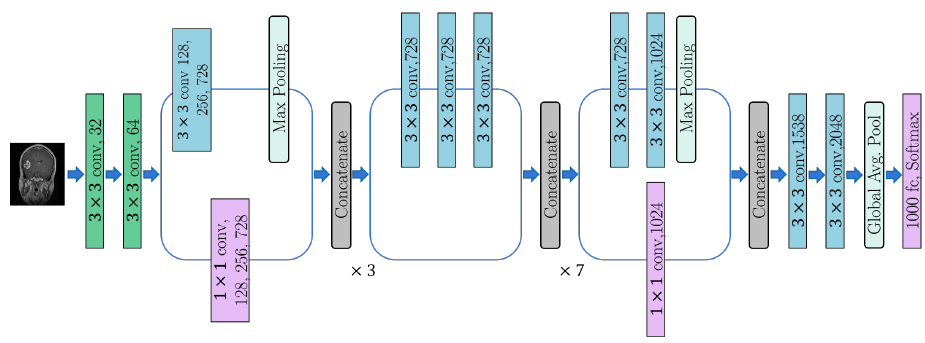
Figure 4. A basic representation of pre-trained Xception